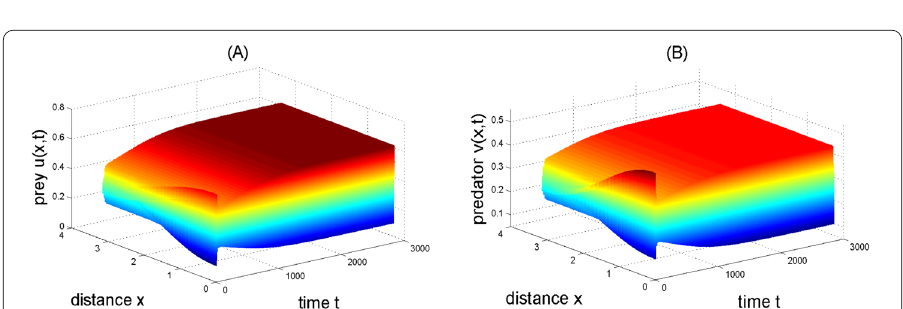
Figure 3 The positive equilibrium ( u ∗ , v ∗ ) of system (1.2) is asymptotically stable when the parameter τ = 0.9063 < 0.9363. Here we choose to set parameter values as d 1 = 0.05, d 2 = 0.1, γ = 1, β = 0.6, c = 0.75, and set the initial values as u ( x ,0) = 0.4094 + 0.05cos x , v ( x ,0) = 0.3517 + 0.05cos x